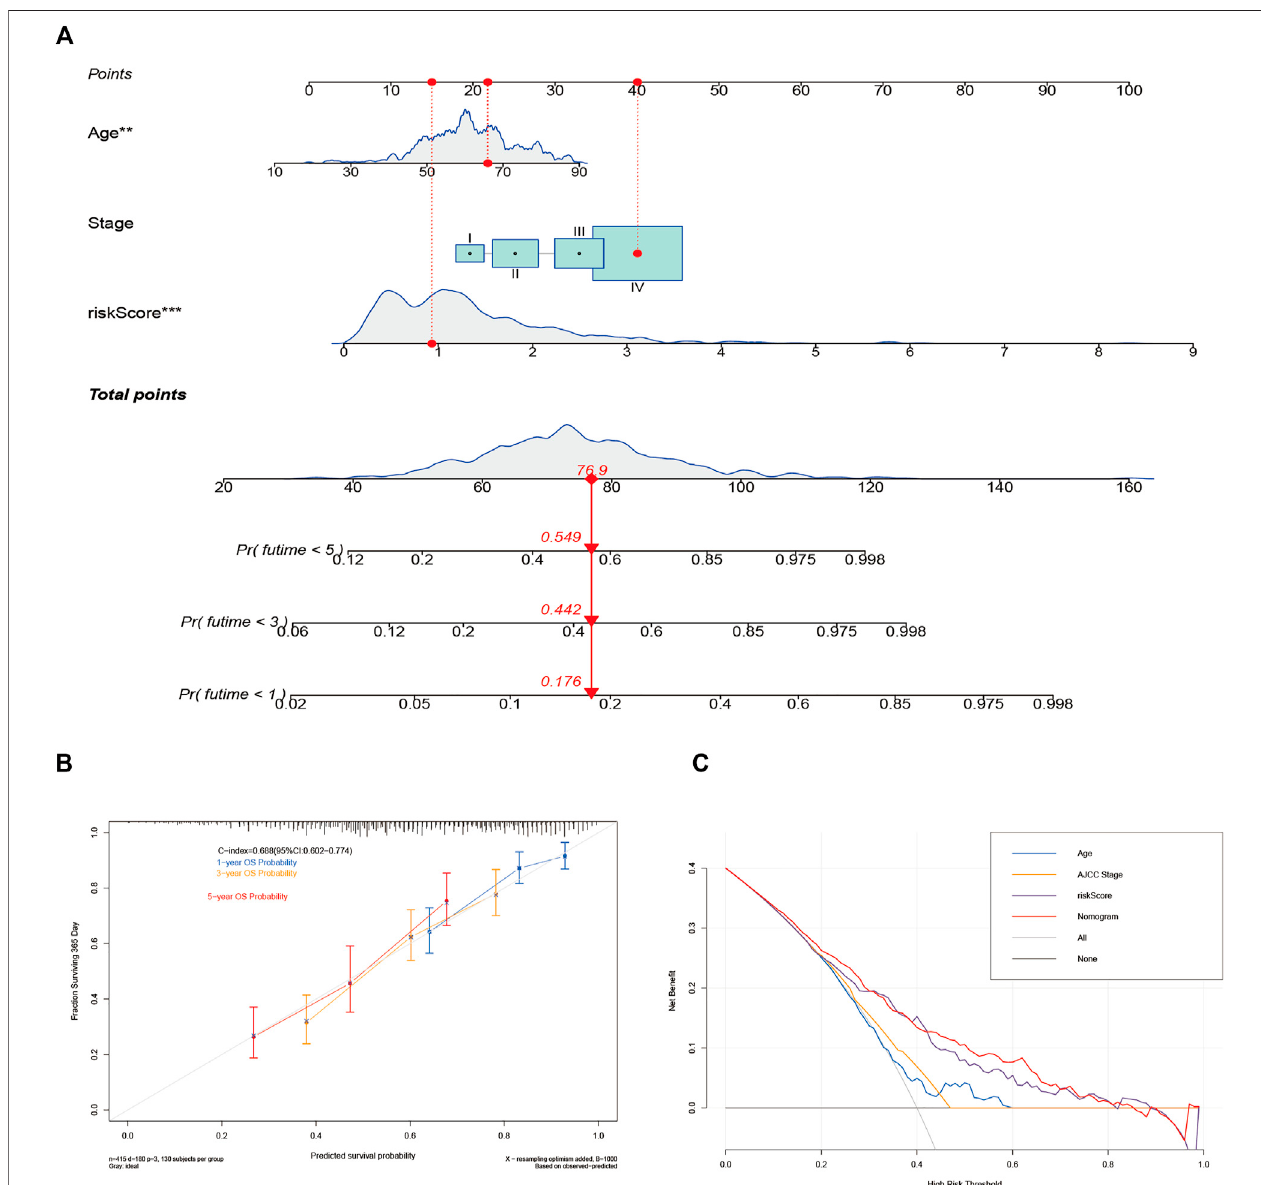
FIGURE 6 | Construction and validation of the nomogram for predicting the overall survival (OS) of patients with head and neck squamous cell carcinoma. (A) The nomogram for predicting the OS of patients at 1, 3, and 5 years. (B) Calibration curves of the nomogram for OS prediction at 1, 3, and 5 years. (C) Decision curve analysis for the prediction of 1-, 3-, and 5-year